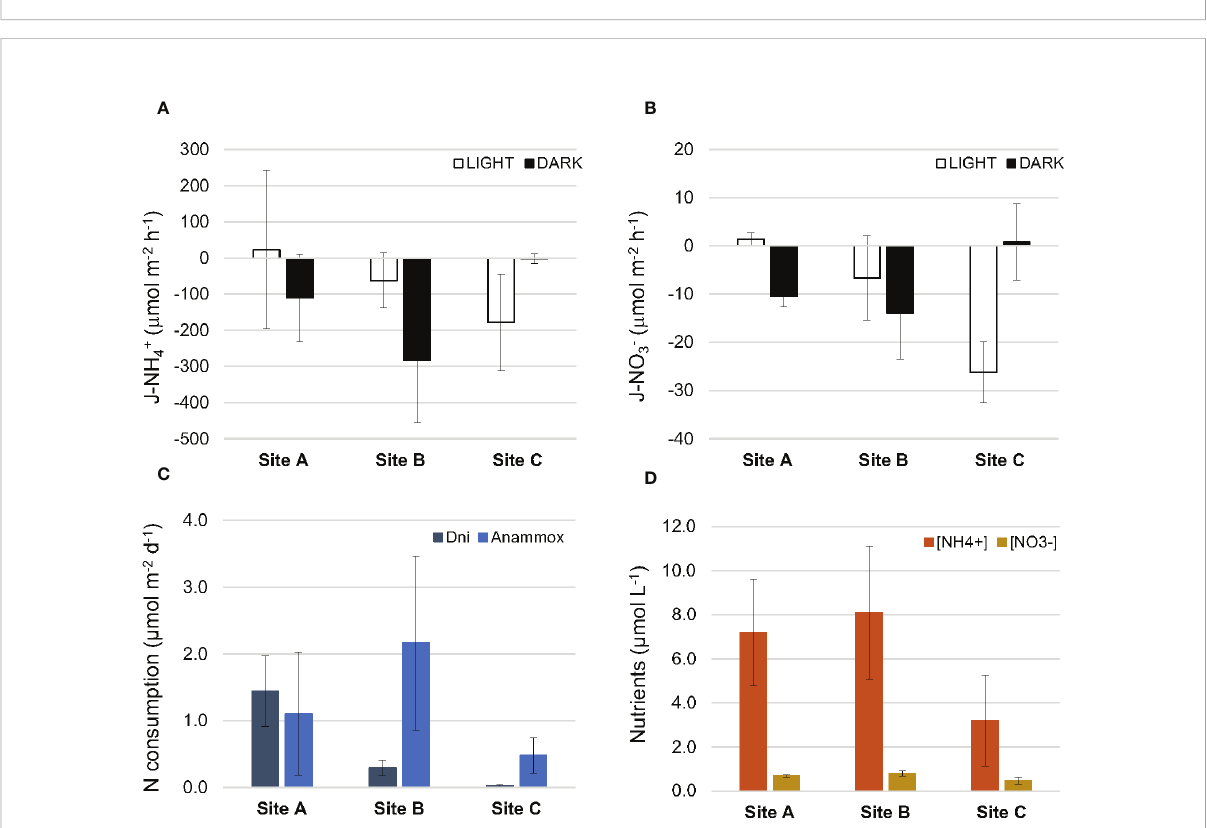
FIGURE 6 Net community fl uxes of ammonium (A) , and nitrate (B) . Daily community nitrogen consumption rates (denitri fi cation (Dni) and anammox) (C) . Nutrient concentrations (ammonium and nitrate) recorded in the water at the beginning of the incubation (D) . Bars are mean ±